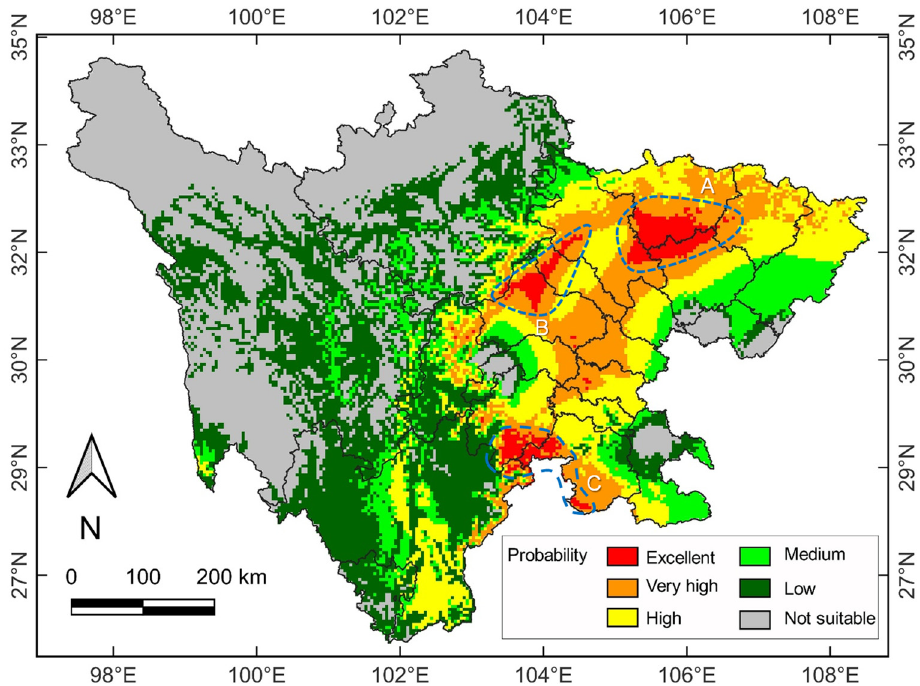
Figure 3. Distribution pattern of six categories of habitat suitability of venerable trees in Sichuan based on the current climate scenario. The results were obtained from the model predictions of BIOCLIM using DIVA-GIS. Different colors, from grey to red, denote the gradation from not suitable to excellent habitat suitability, and hence the probability of tree occurrence. The A, B and C annotations indicate the three largest patches of excellent suitability.